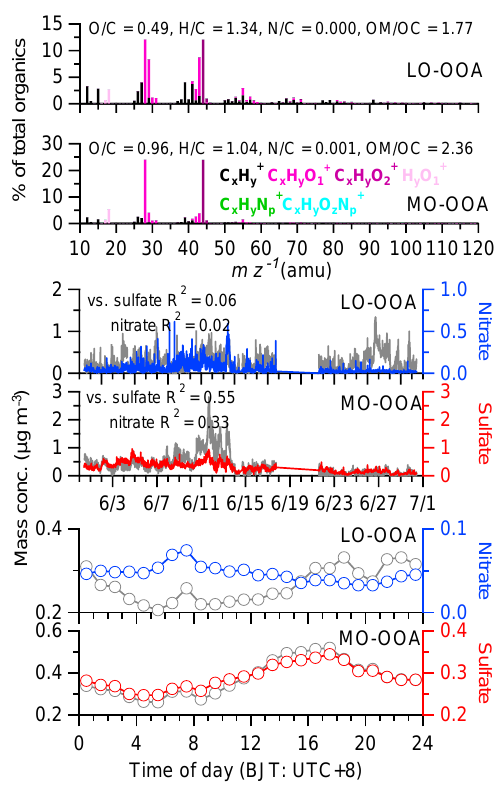
Figure 10. PMF results of (a) high-resolution mass spectra col- ored according to six ion categories for LO- and MO-OOA, respec- tively, (b) temporal variations of the OA factors and corresponding comparison with tracer species (sulfate and nitrate), and (c) diurnal variations of the mass concentration of the OA factors and tracer